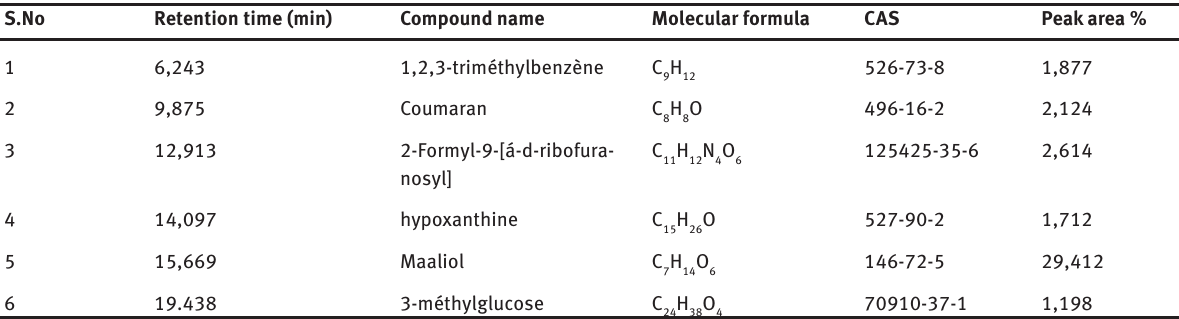
Table 2 : Phytocomponents identified in B.dioica roots extract by GC-MS analysis.